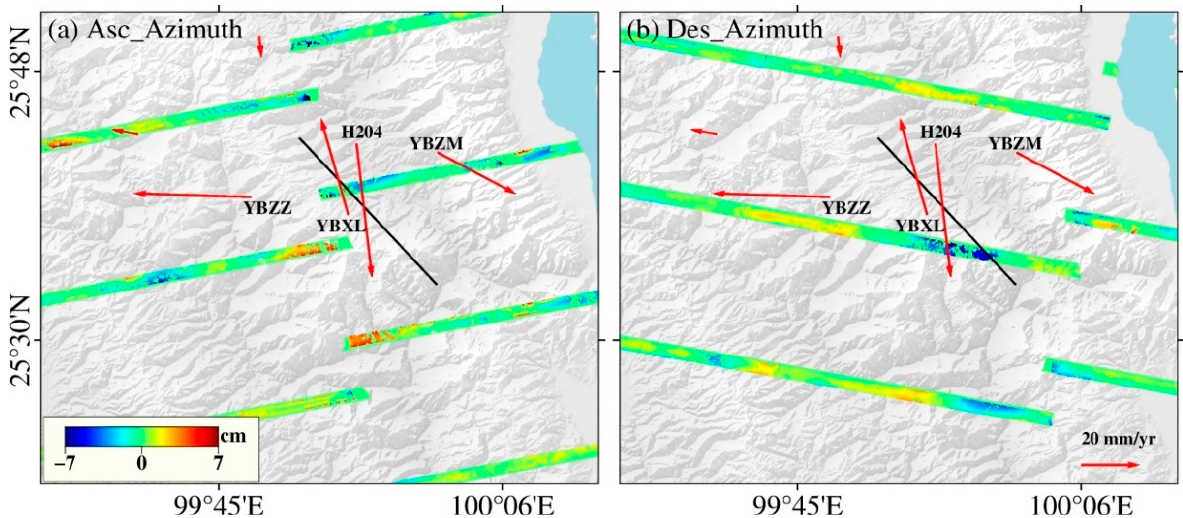
Figure 4. ( a ) Ascending and ( b ) descending BOI-derived azimuth displacements of the 2021 Yangbi earthquake. Red arrows indicate the GPS horizontal deformation vectors. The black line is the seismogenic fault used in source modeling.